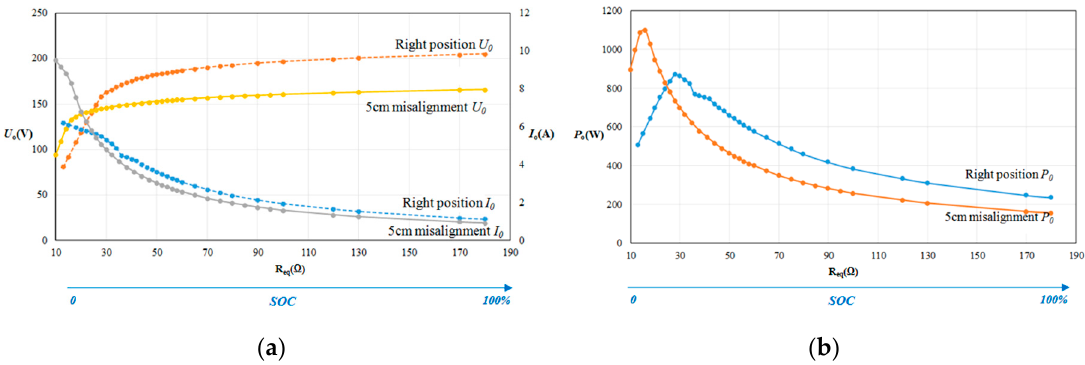
Figure 27. Variation with equivalent resistance at different displacements in the x axis: ( a ) output voltage and current; ( b ) system output power.